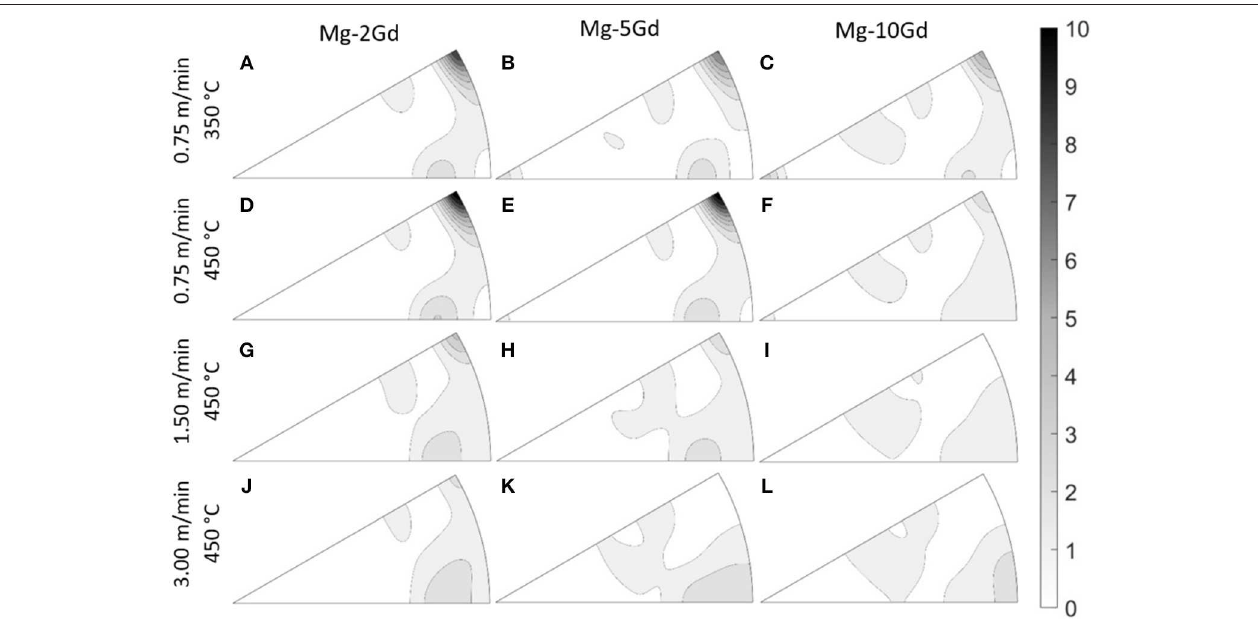
FIGURE 5 | Texture development of as extruded conditions. Bottom left h 0001 i pole, bottom right h 1120 i pole and top right h 1010 i pole with intensities ranging from 0 to 10. (A–C) Extrusion at 0.75m/min and 350 ◦ C; (D–F) extrusion at 0.75m/min and 450 ◦ C; (G–I) extrusion at 1.50m/min and 450 ◦ C; (J–L) extrusion at 3.00m/min and 450 ◦